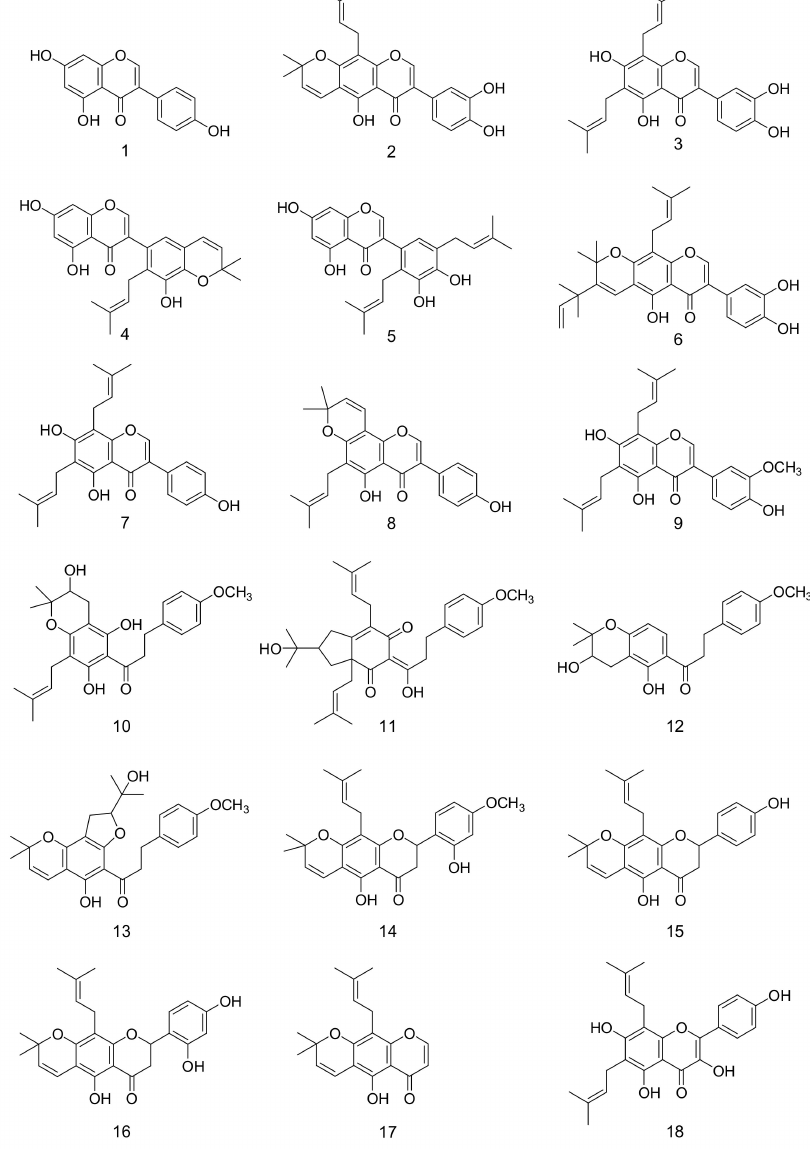
Figure 1. Chemical structures of phenolic metabolites ( 1 – 18 ) from F .